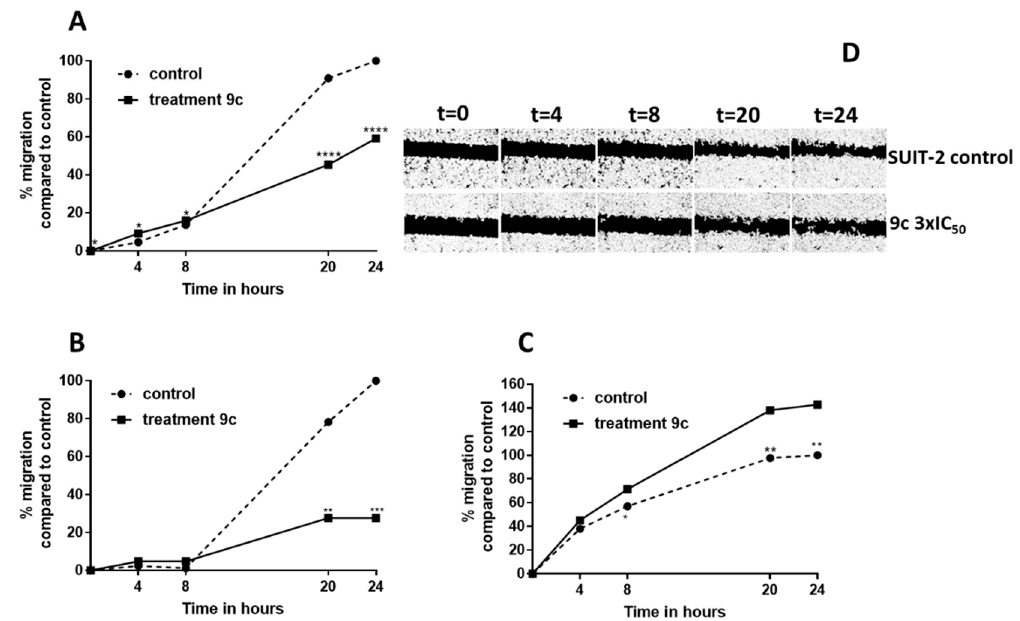
Figure 3. Modulation of migration rate in SUIT-2, Capan-1 and Panc-1 cells treated with imidazo[2,1- b ][1,3,4]thiadiazole compound 9c . The percentages of migration were monitored over time at 0, 4, 8, 20, 24 h in SUIT-2 ( A ), Capan-1 ( B ) and Panc-1 ( C ) cells treated with compound 9c at concentration of 3xIC 50 values. Points represent the means of at least six different scratch areas. SEM were always below 10%. All the P values were calculated with Student’s- t -test. **** p < 0.0001, *** p < 0.001 ** p < 0.01, * p < 0.05. ( D ) Representative images of the scratch areas of SUIT-2 cells monitored over time (T = 0 and at 4, 8, 20 and 24 h from the start of the treatment). ( Upper panels ) untreated cells; ( lower panels ) cells treated with compound 9c . Original magnification 5×.